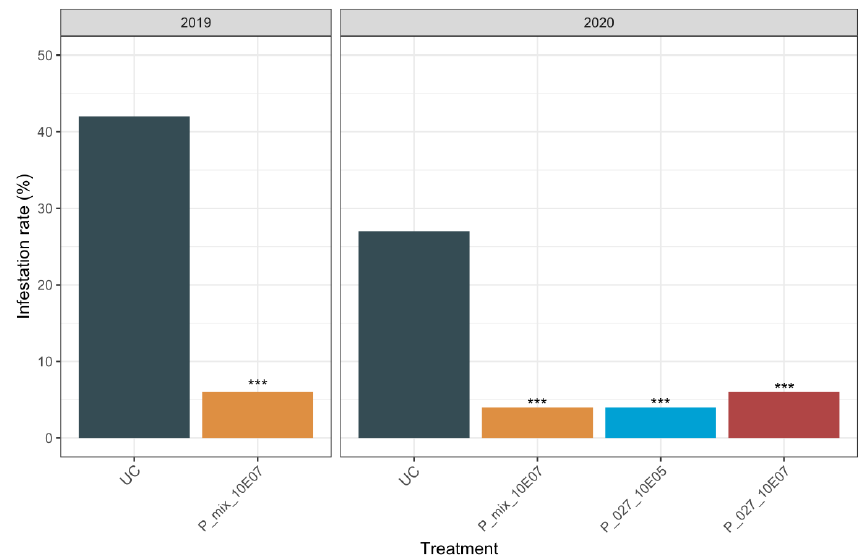
Figure 1. Comparison of HRD infestation rate between untreated plants and plants treated with Paenibacillus xylanexedens inocula at the end of the greenhouse trial in two consecutive growing seasons (2019 and 2020). The infestation rate was calculated as the ratio of tomato plants showing HRD symptoms (N = 48). All plants were artificially inoculated with rhizogenic Agrobacterium ST07.18/001. Either no BCO was applied (untreated control; UC) or plants were treated with different BCO inocula—a mixed inoculum of 10 7 CFU/mL Paenibacillus xylanexedens ST15.15/027 and AD117 (P_mix_10E07), or a single strain inoculum (ST15.15/027) in a density of 10 5 CFU/mL (P_027_10E05) or 10 7 CFU/mL (P_027_10E07). Significance is presented against the untreated control of the respective year: *** represents a p -value < 0.001.